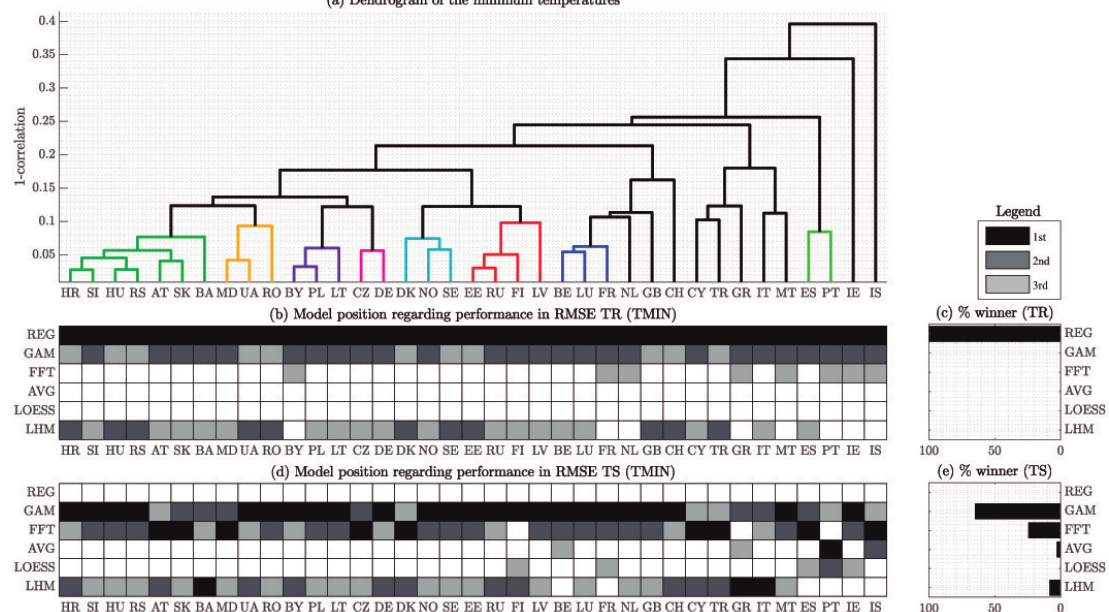
Figure 9. Results for the minimum temperatures and all the tested methods: ( a ) dendrogram of the 37 weather stations, first three methods with lower ( b ) in-sample and ( d ) out-of-sample error, and percentage of times winner for each method: ( c ) in-sample and ( e ) out-of-sample.